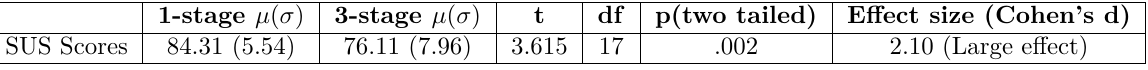
Table 5. Paired-Samples t-test – SUS.